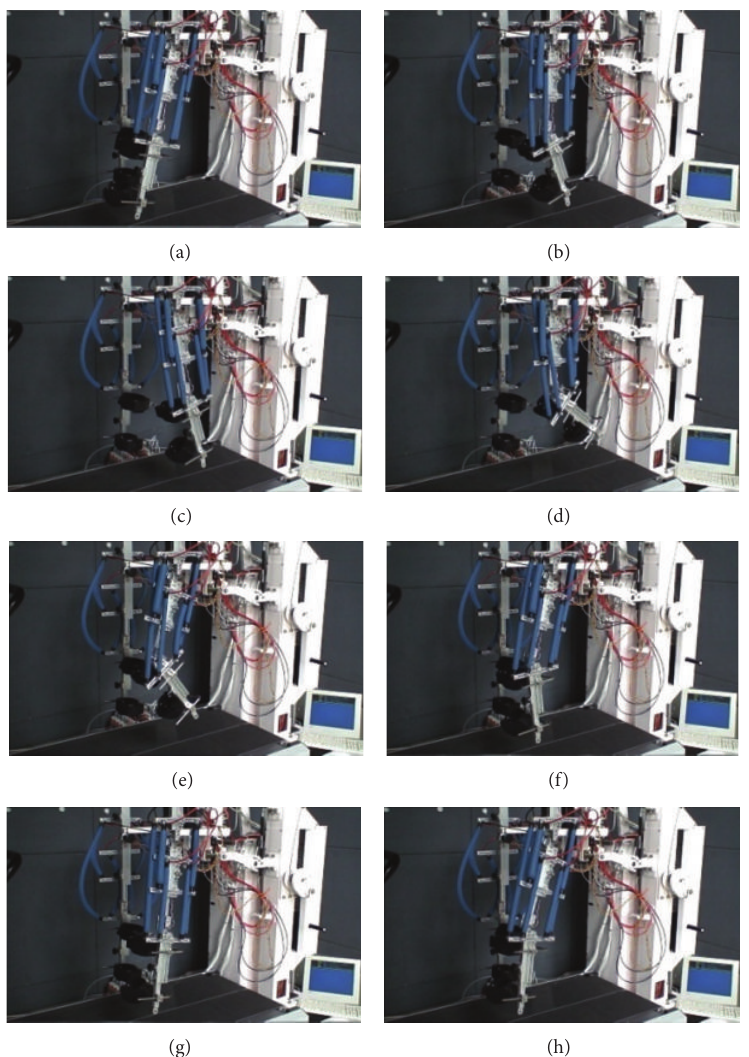
Figure 4: Control of the leg orthosis without a subject